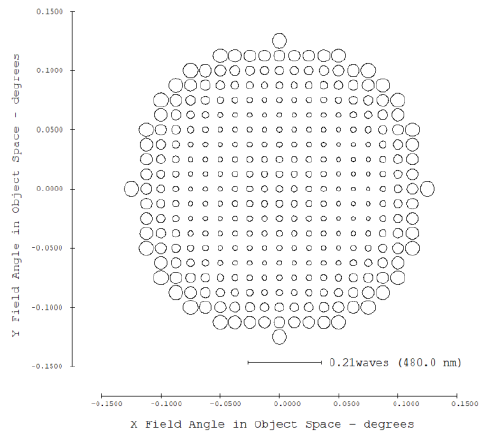
Figure 5 RMS wavefront